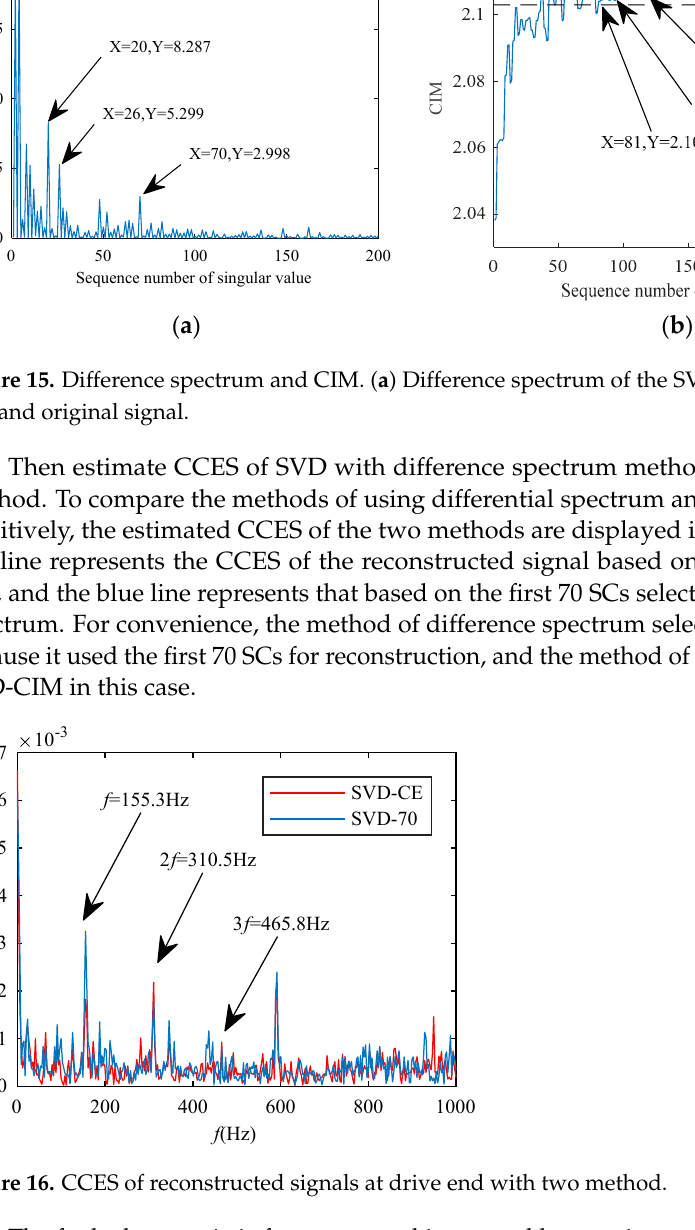
Figure 15. Difference spectrum and CIM. ( a ) Difference spectrum of the SVD. ( b ) CIM between the SCs and original signal.